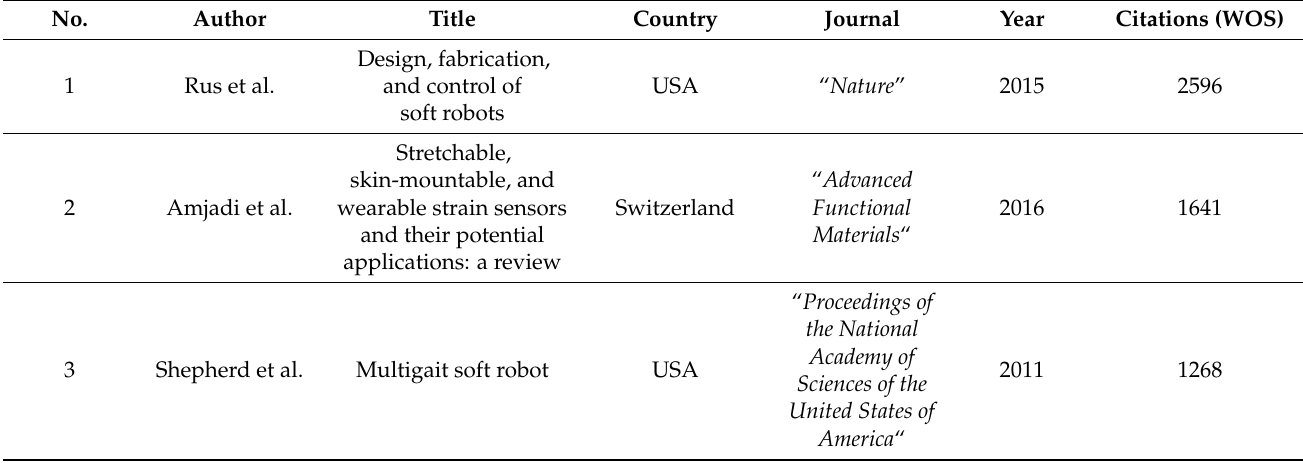
Table 5. Top 10 most cited articles in the field from 2008 to 2022 on